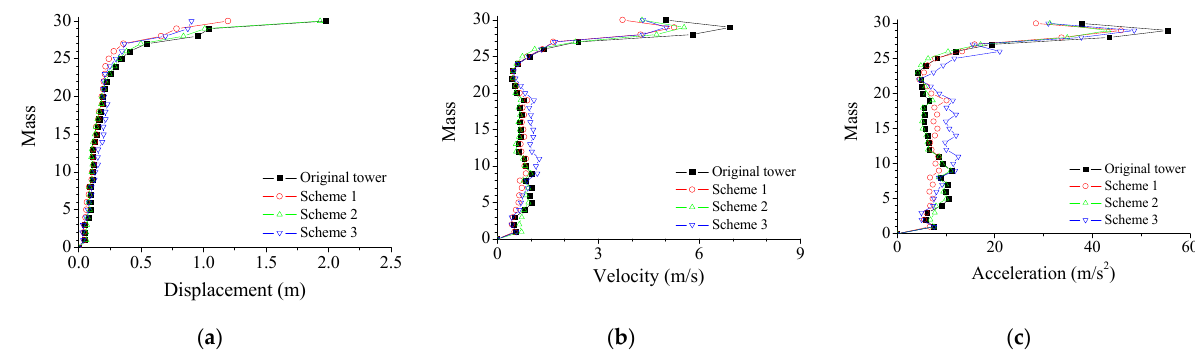
Figure 7. Comparison of different control schemes. ( a ) Displacement; ( b ) Velocity; ( c ) Acceleration.